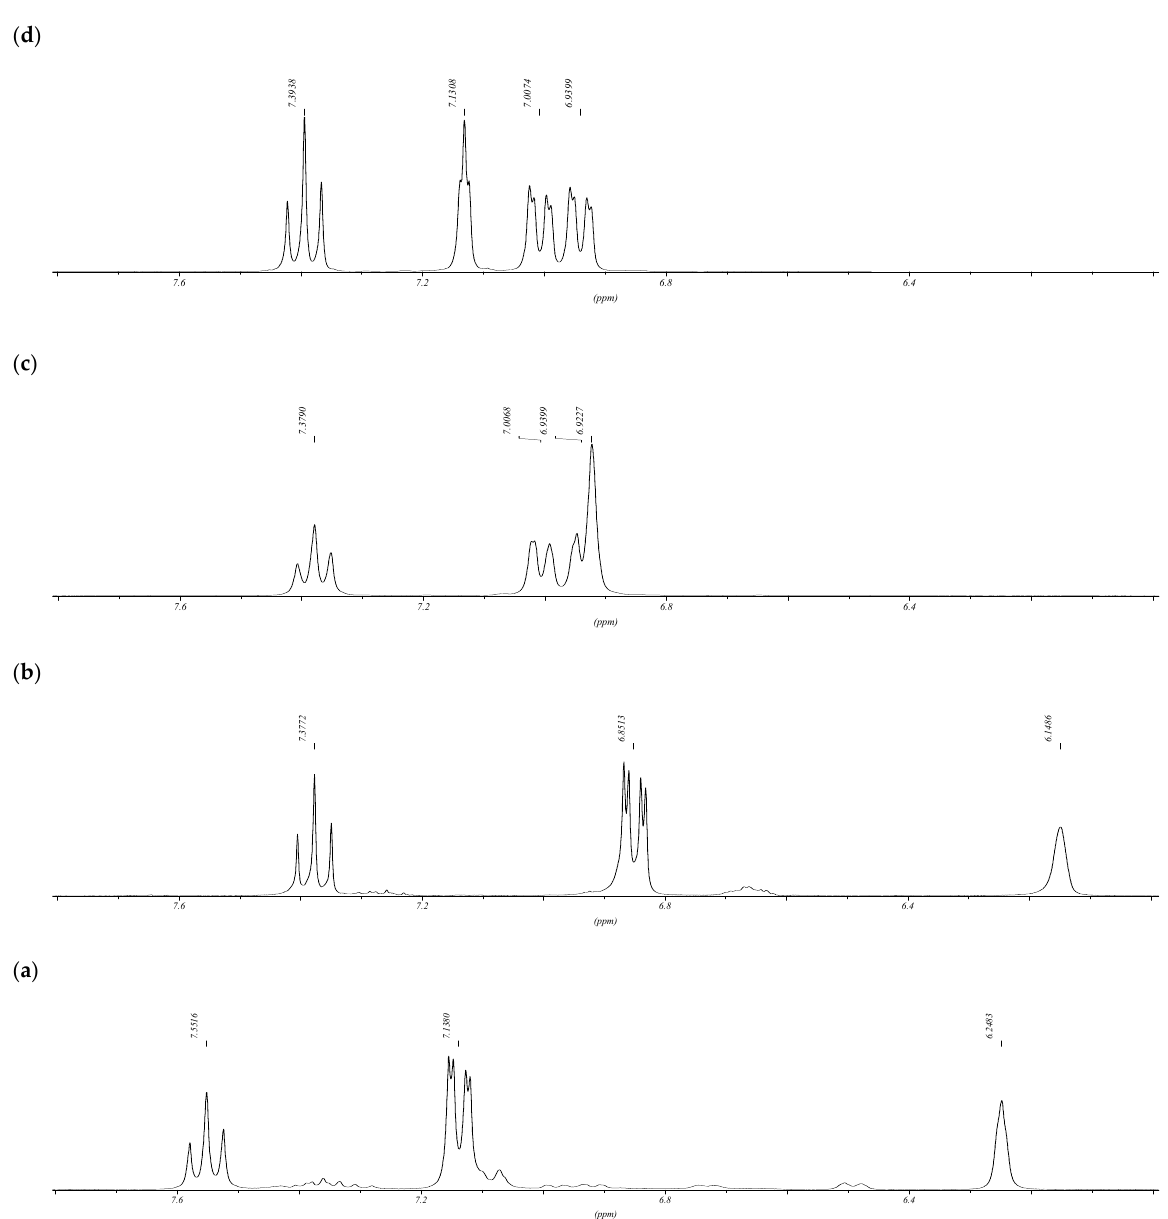
Figure 2. 1 H NMR spectra (acetone-d6) of dioxadithiacalix[4]arenes 8 ( a ), tetraoxadithiacalix[6]arene 12 ( b ), tetraoxathiacalixarene 15 ( c ), pentaphenyl ether 13 ( d ).